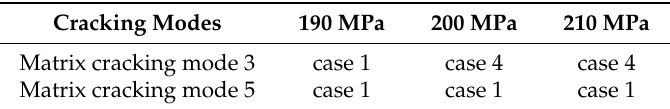
Table 2. The interface slip type of matrix cracking mode 3 and mode 5 corresponding to different peak stresses of cross-ply SiC/SiC